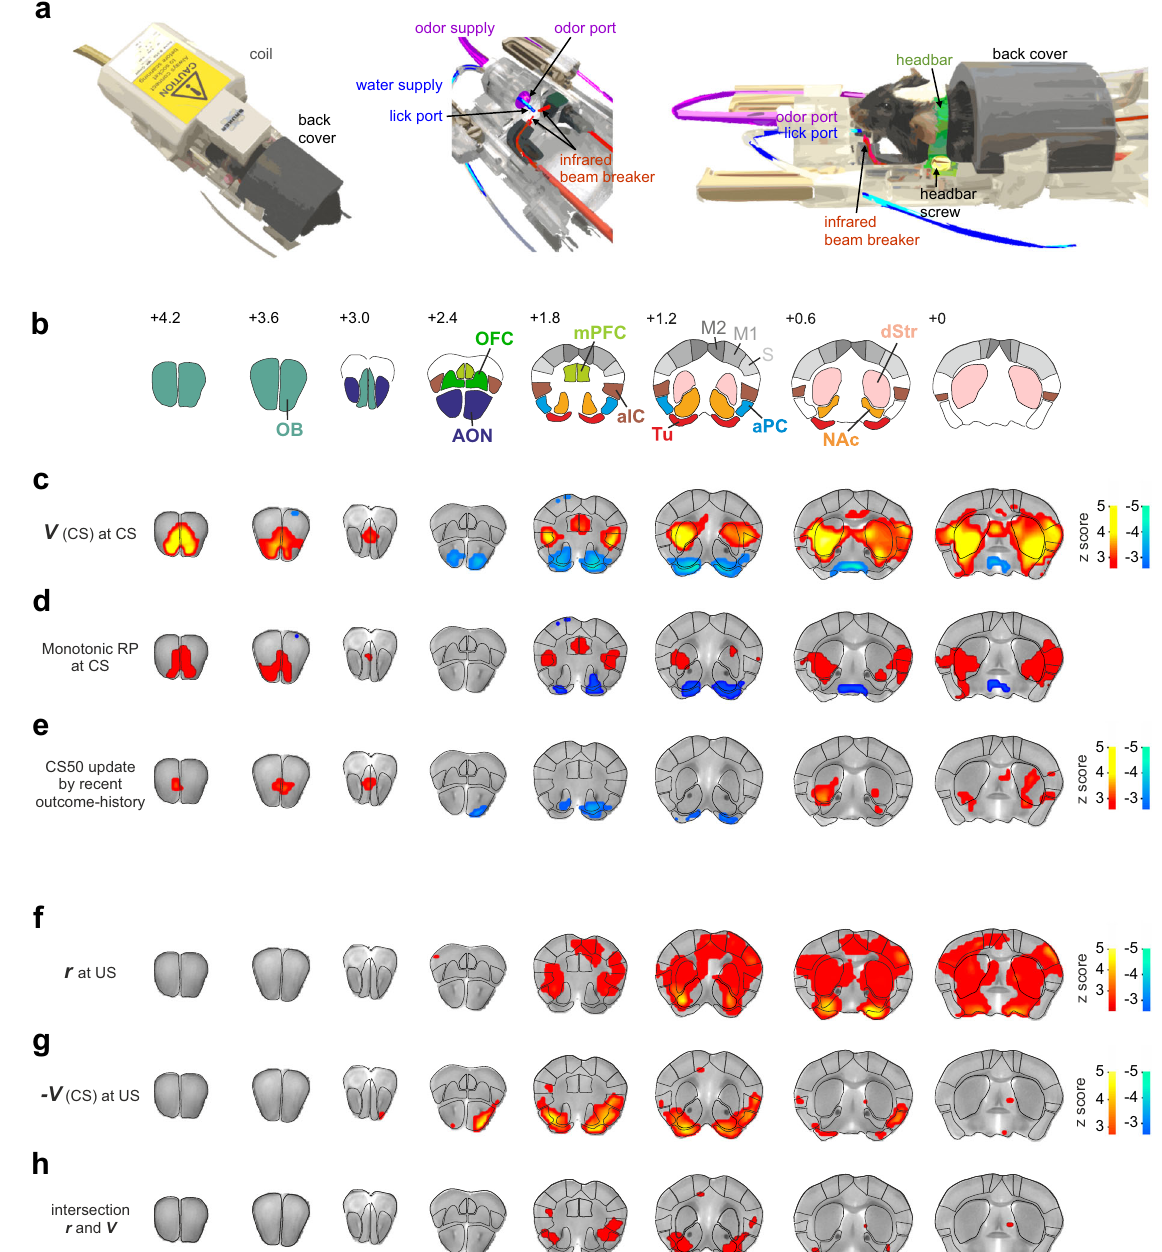
Fig. 3 Olfactory-association-learning network expresses monotonic RP and prediction error components. a Illustration of the MRI-compatible behavioral setup with MRI coil (left) comprising an odor port, a lick port, respective supply tubes, an infrared beam breaker, a head- fi xation system, and a back cover (middle and right). b Anatomical illustration of olfactory, striatal and higher-order regions, mapped onto an MRI template brain (location from Bregma indicated in mm). aIC agranular insular cortex, AON anterior olfactory nucleus, aPC anterior piriform cortex, dStr dorsal striatum, M1/M2 motor cortex, mPFC medial prefrontal cortex, NAc nucleus accumbens, OB olfactory bulb, OFC orbitofrontal cortex, S somatosensory cortex, Tu olfactory tubercle. c Group-level Z-statistical maps showing BOLD correlates of RP values V ( CS ) from the TD model ( n = 51 sessions in 18 animals). Statistical threshold was set to P < 0.025 false discovery rate (FDR)-corrected, for two-sided testing (as for the other maps unless otherwise indicated). Red color spectrum indicates areas with positive correlations to RP values, while blue colors indicate negative correlations. The regression revealed recruitment of olfactory and striatal brain regions with opposing effects on BOLD. d Within the regions associated with V ( CS ) from ( c ), monotonic RP (CS100 > CS50 > CS0 in red or CS100 < CS50 < CS0 in blue) was represented mainly in prefrontal, insular, striatal regions, and olfactory bulb. Maps were created by intersecting contrast maps CS100 > CS50 and CS50 > CS0, each thresholded at P < 0.025 FDR-corrected; and vice-versa: CS100 < CS50 and CS50 < CS0 (see the respective contrast maps in Supplementary Fig. 3e, f). e Recent outcome history modulating the BOLD response to CS50. Within the V ( CS ) regions from ( c ), we tested for a CS50 response enhancement by the reward in the previous CS50 trial. In olfactory and striatal regions, the CS50-associated response was indeed strengthened by a positive outcome history. f – h In the TD model, the prediction error at US is r - V ( CS ). We identi fi ed brain regions correlating with both prediction error components by intersecting the regressor maps of ( f ) r and ( g ) -V(CS) at US, each thresholded at P < 0.05 FDR-corrected. The intersection, shown in ( h ), was largely con fi ned to the lateral NAc, the posterior Tu, and aIC. NATURE COMMUNICATIONS| (2022) 13:3305